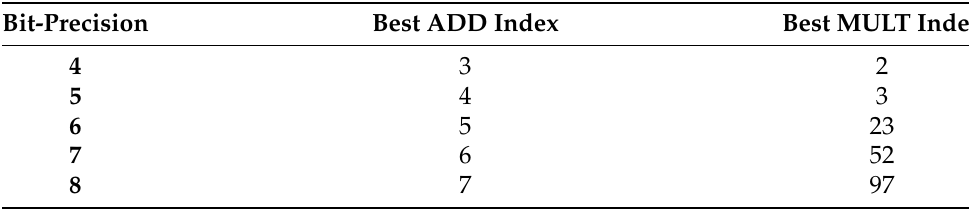
Table A1. Best relative seed index for different use cases depending on the bit-precision.